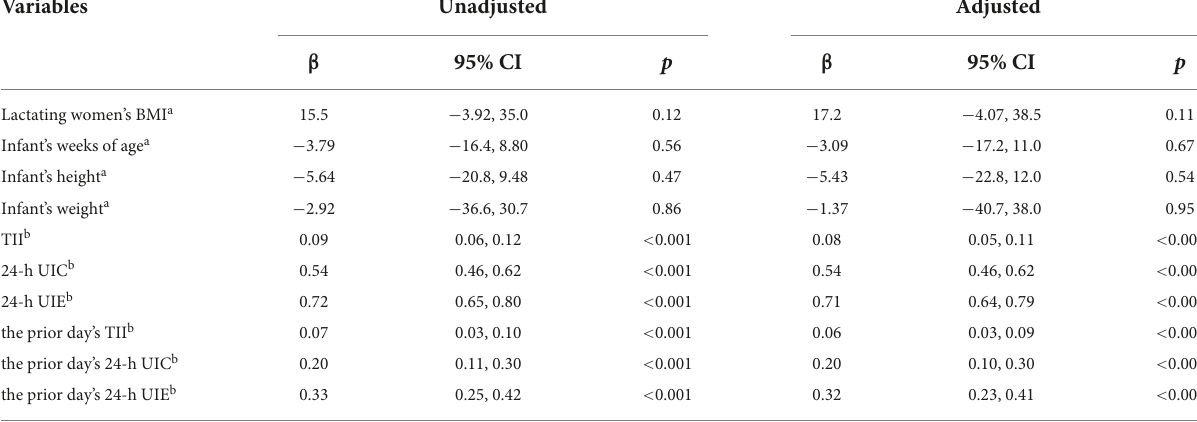
TABLE 7 Linear mixed-effects models of predictors of breast milk iodine concentration (BMIC).